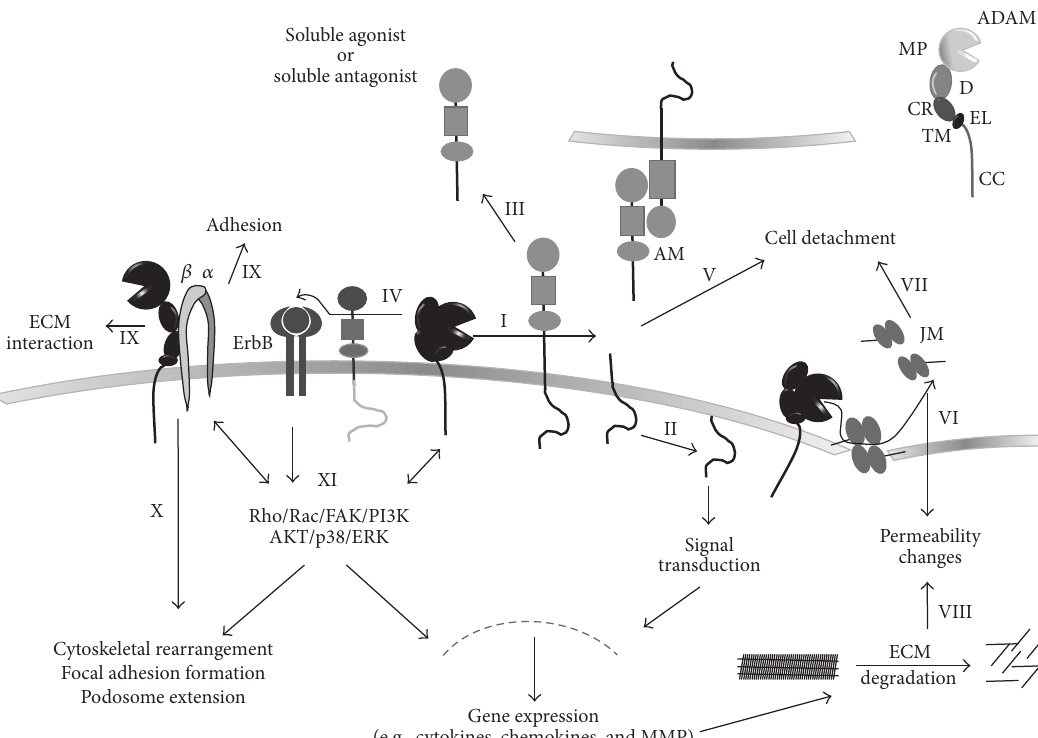
Figure 1: Catalytic and noncatalytic functions of ADAM proteases facilitating cell migration. ADAM proteases interfere with distinct steps of cell migration via a number different effector molecules. This involves proteolytic cleavage or nonproteolytic interactions of the proteases. ADAMs consist of a C-terminal cytoplasmic tail (CC) followed by a transmembrane domain (TM), an EGF-like domain (EL), a cysteine- rich domain (CR), and a disintegrin domain (D) and an extracellular metalloproteinase domain (MP) (ADAM). ADAM proteases cleave transmembrane surface molecules close to the plasma membrane, a process called shedding, requiring a zinc atom in the active site of the metalloproteinase domain (I). This results in the release of a soluble ectodomain and the production of a cell-associated fragment consisting of the transmembrane and cytoplasmic domain. The remaining fragment can undergo further regulated intramembrane proteolysis by 𝛾 - secretase (II) at last functioning as transcription factor (e.g., Notch). ADAM activity can be regulated by activation of a precursor protein (e.g., pro-MMP9). The released ectodomain may function either as agonist like the chemokine CXCL16 and the ErbB ligands HB-EGF and neuregulin or as antagonist like soluble JAM-A or RAGE (III). The release of ErbB ligands leads to transactivation of ErbB receptors in cis and trans (IV). The inactivation of ligands (i.e., adhesion molecules (AM)) can lead to the detachment of bound receptor complexes and attached cells (i.e., L-selectin, MAC-1) (V). The cleavage of junction molecules (JM, i.e., cadherins) results in changes of permeability (VI), facilitating the transmigration of inflammatory cells, the invasion of cancer cells, and the dissemination resulting in metastasis and angiogenic processes (VII). The permeability is further regulated by ECM degradation, by either direct action of ADAM proteases (i.e., ADAM9) or the regulation of MMPs (VIII). With their disintegrin-like domain, ADAMs can directly interact with adhesion molecules and ECM proteins (IX). The integrin (indicated by 𝛼/𝛽 ) interaction/activation results in cytoskeletal rearrangement, focal adhesion formation, and podosome extension (X). Integrin, ADAM activation, and ErbB receptor transactivation result in different signaling pathways including the activation of Rho, Rac, FAK, PI3K, AKT, p38, and ERK, all further regulating ADAM and integrin activity as well as gene expression (XI). The exact mechanism of cell migration can differ between rapidly migrating leukocytes and tissue cells. However, the involved surface molecules, the signal transduction pathways, and the molecular machinery show a considerable degree of overlap for the action of ADAM proteases in inflammatory cell recruitment, angiogenesis, reepithelialization, cancer cell detachment and adhesion, and the intra- and extravasation during